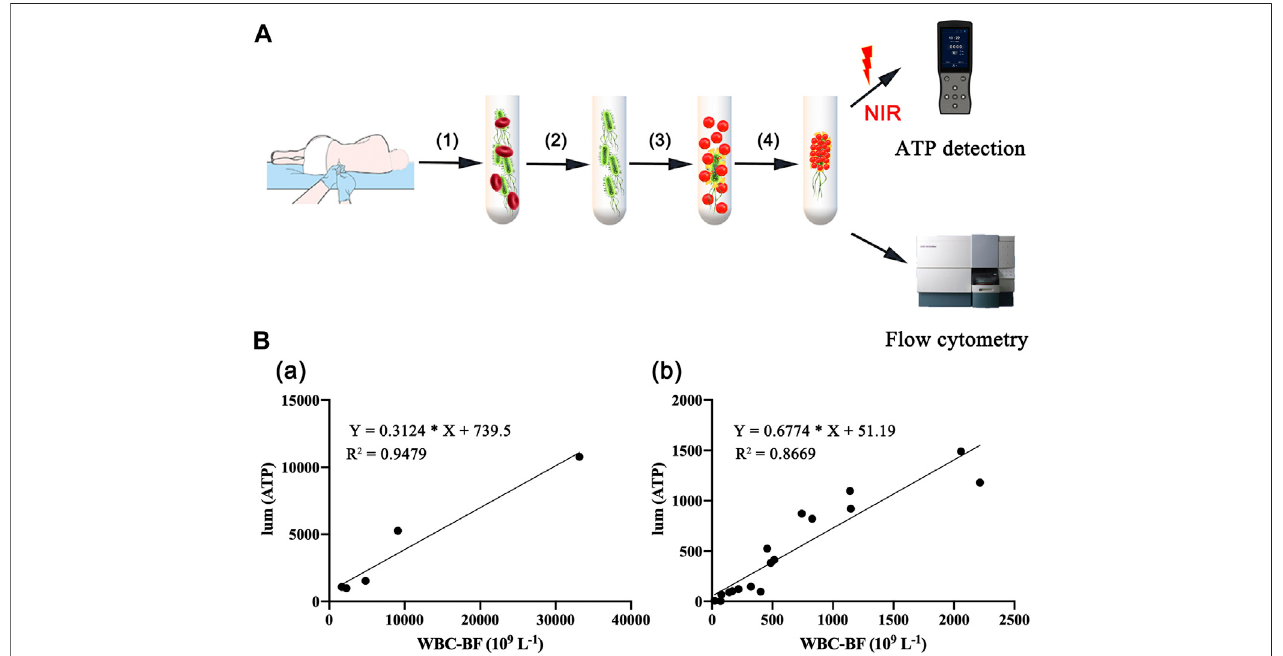
FIGURE4| Rapiddetectionofintracranialinfectioninpatients. (A) DetectionofATPinCSFsamplesfrom30patients,including fi vepatientswithclinicallycon fi rmed intracranial infections, 17 patients with suspected intracranial infection, and eight patients without intracranial infection. (B) Correlation analysis between white blood cell count and ATP value in CSF. (a) CSF of fi ve patients with con fi rmed postoperative intracranial infection. (b) CSF of 17 patients with suspected postoperative intracranial infection.